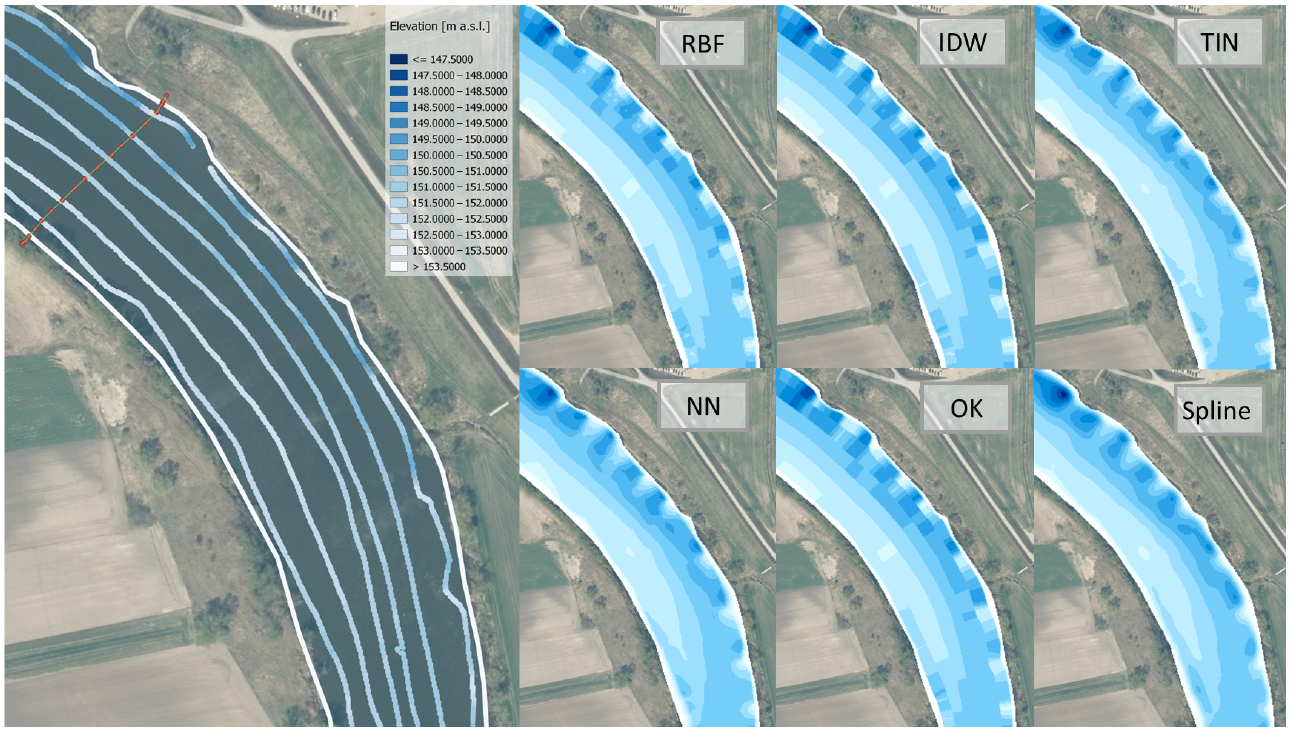
Figure 7. Example of RBMs generated for a small non-straight part of the Odra Cascade (reach from the barrage “K ˛aty” to the barrage “Groszowice”) using six different interpolation